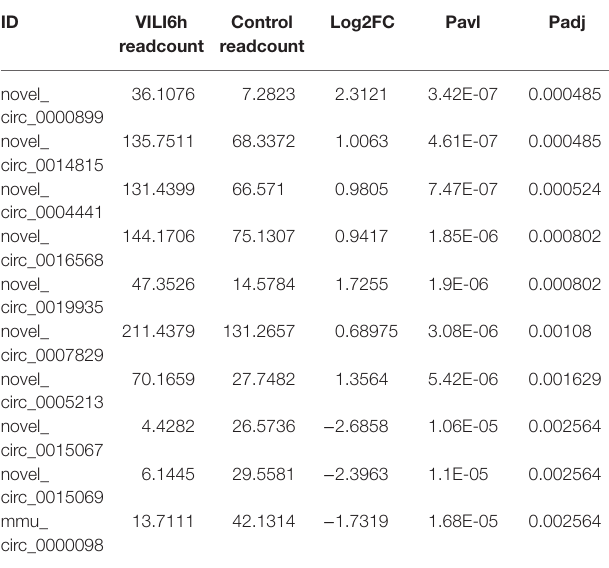
TABLE 1 | Top 10 differently expressed circRNA in microarray